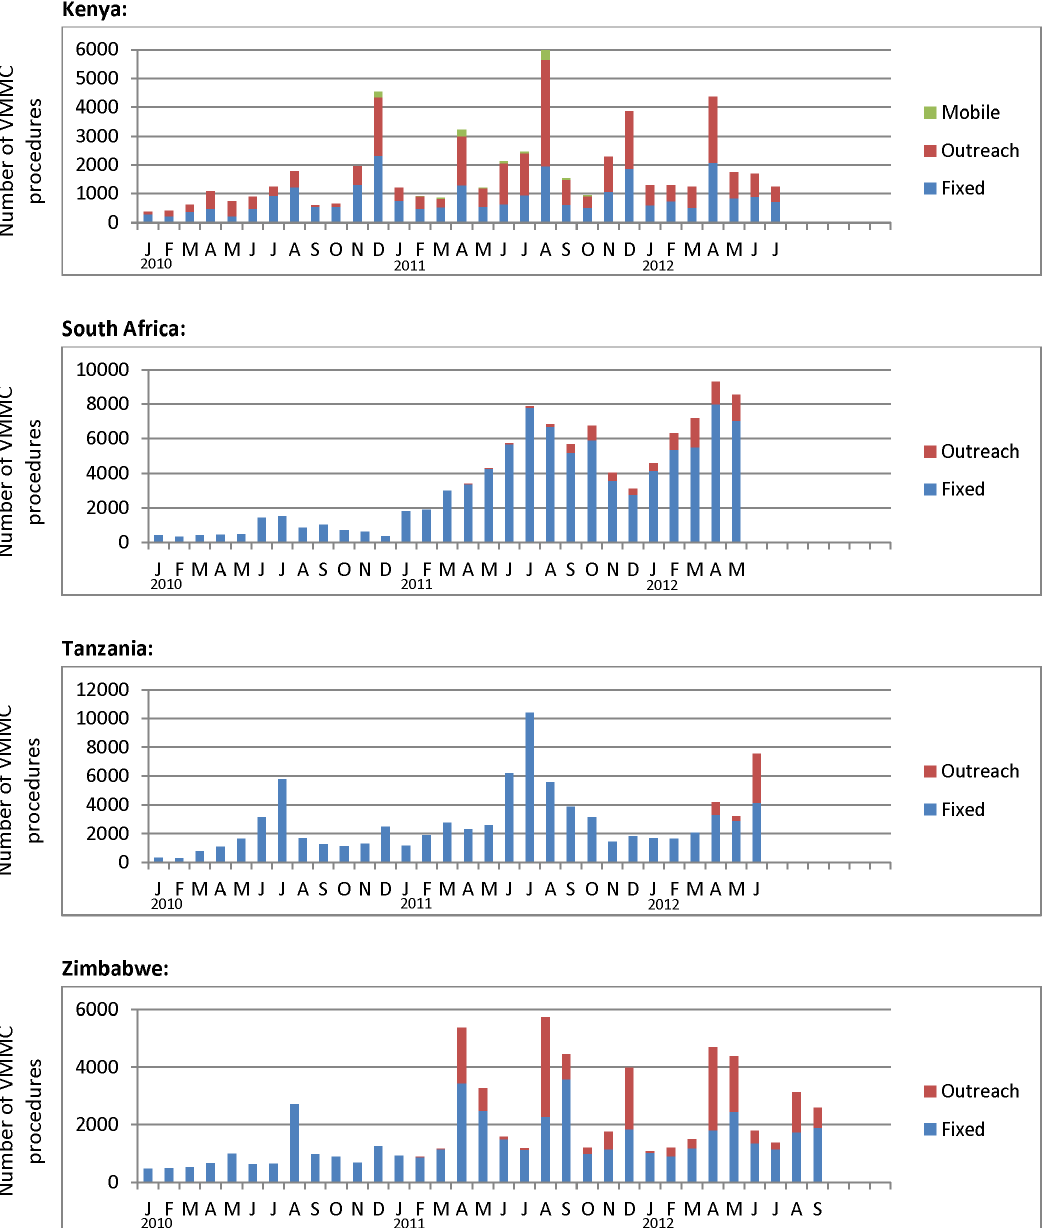
Figure 2. Number of VMMC procedures performed by month, type of site, and country, January 2010 – mid-2012.